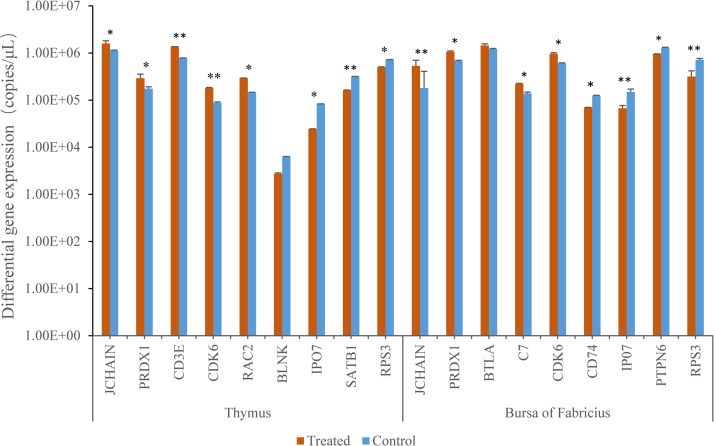
The expressions of immune-related differential genes were confirmed by absolute qPCR.In the figure, “*” above the column indicates significant difference (P<0.05), while “**” indicates extremely significant difference (P<0.01).